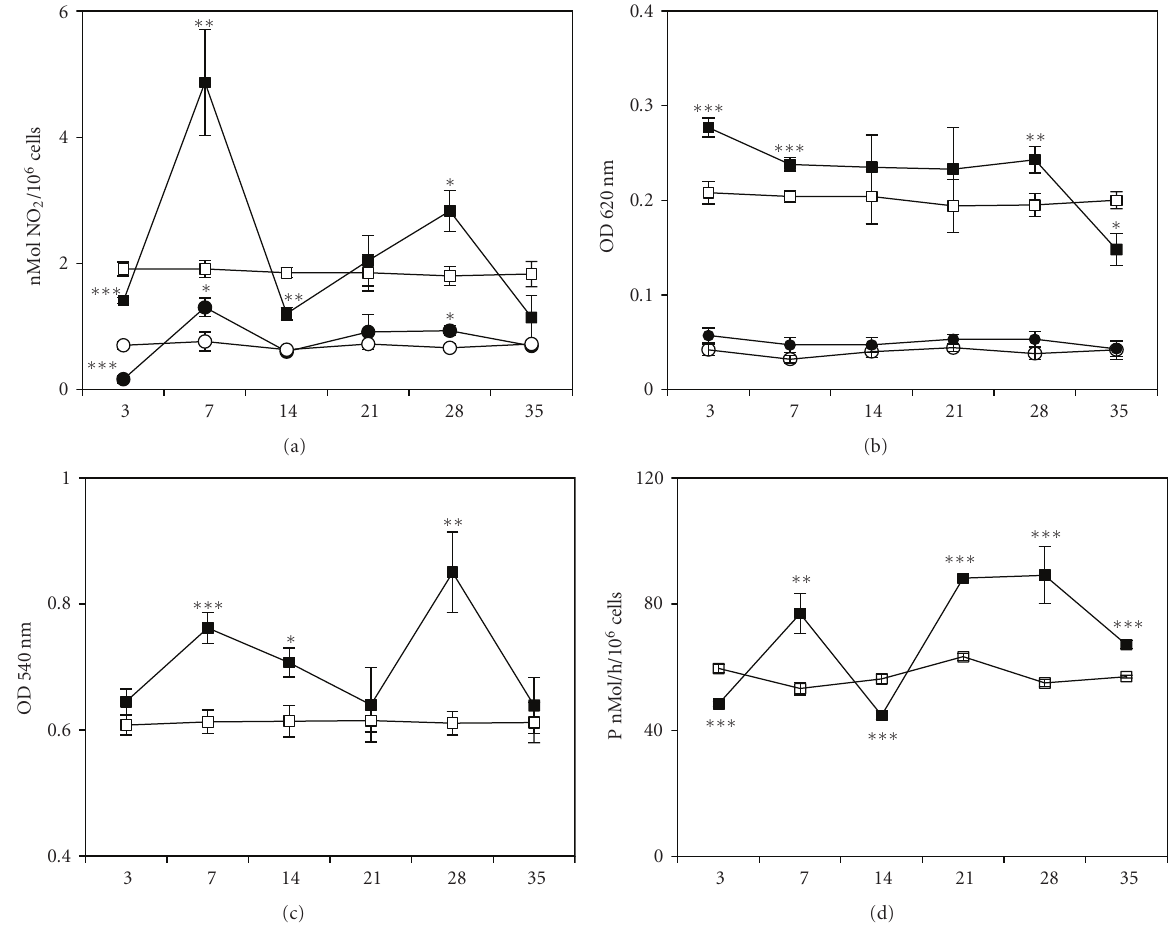
Figure 1: Dynamics of functional activity of peritoneal macrophages from mice bearing hepatoma 22a. X -axis: time after inoculation of the tumor, days. Y -axis: (a) Spontaneous NO 2 -production by macrophages from (cid:5) —control mice and (cid:2) —tumor-bearers; NO 2 - production in macrophages stimulated with 10 ng/mL LPS during 24h,nM/h/10 6 cells: (cid:2) —in control mice and (cid:3) —in tumor-bearers. (b) Spontaneous NBT-test: (cid:5) —in macrophages from control mice, (cid:2) —from tumor-bearers; NBT-test in macrophages stimulated with 1 μ g/mL TPA during 1 h: (cid:2) —in control mice, (cid:3) —in tumor-bearers. Optical density was measured at λ = 620 nm. (c) Fluid-phase pinocytosis of neutral red during 1h, optical density was measured at λ = 540 nm; (cid:2) —macrophages from control mice, (cid:3) —from tumor-bearers. (d) 5 (cid:2) - nucleotidase activity was measured by colorimetric estimation of inorganic phosphate released from AMP at λ = 690 nm, P nM/h/10 6 cells; (cid:2) —macrophages from control mice, (cid:3) —from tumor-bearers. Each point represents the results of 4 independent experiments tested in quadriplicates (M ± SEM). Control mice received PBS. ∗ P < . 05, ∗∗ P < . 01, ∗∗∗ P < . 001 compared to control